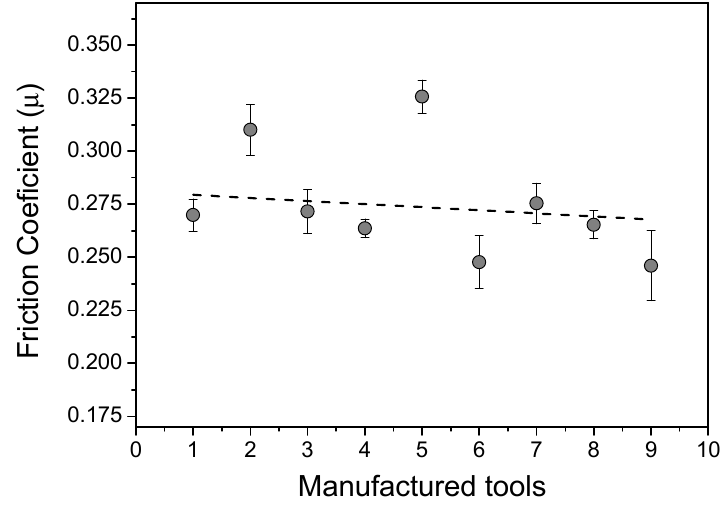
Figure 4. Comparison between the friction coefficients and each manufactured tool in this work.